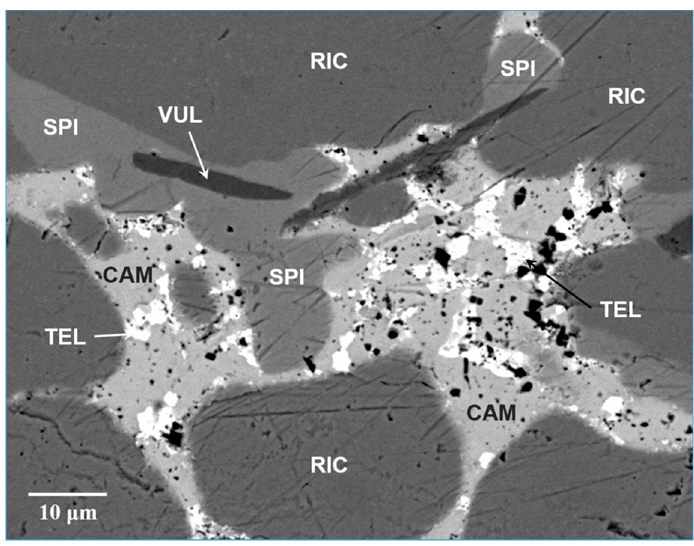
Figure 1. Scanning Electron Microscopy-BackScattered Electron (SEM-BSE) image of spiridonovite (SPI) associated with cameronite (CAM), rickardite (RIC), vulcanite (VUL) and tellurium (TEL). Spiridonovite crystals are black, show metallic luster and black streak, and are not fluorescent. Mohs hardness, estimated from the Vickers measurements, is ~3. Micro-indentation measurements, carried out with a CORE micro-indentation system, give a mean value of 158 kg · mm − 2 (range 145–170). Tenacity is brittle, and cleavage is not observed. Parting is not observed, and fractures are irregular. The density could not be determined due to the small grain size. The calculated density is 4.6 g·cm − 3 , using the empirical formula and X-ray single-crystal data (see below).